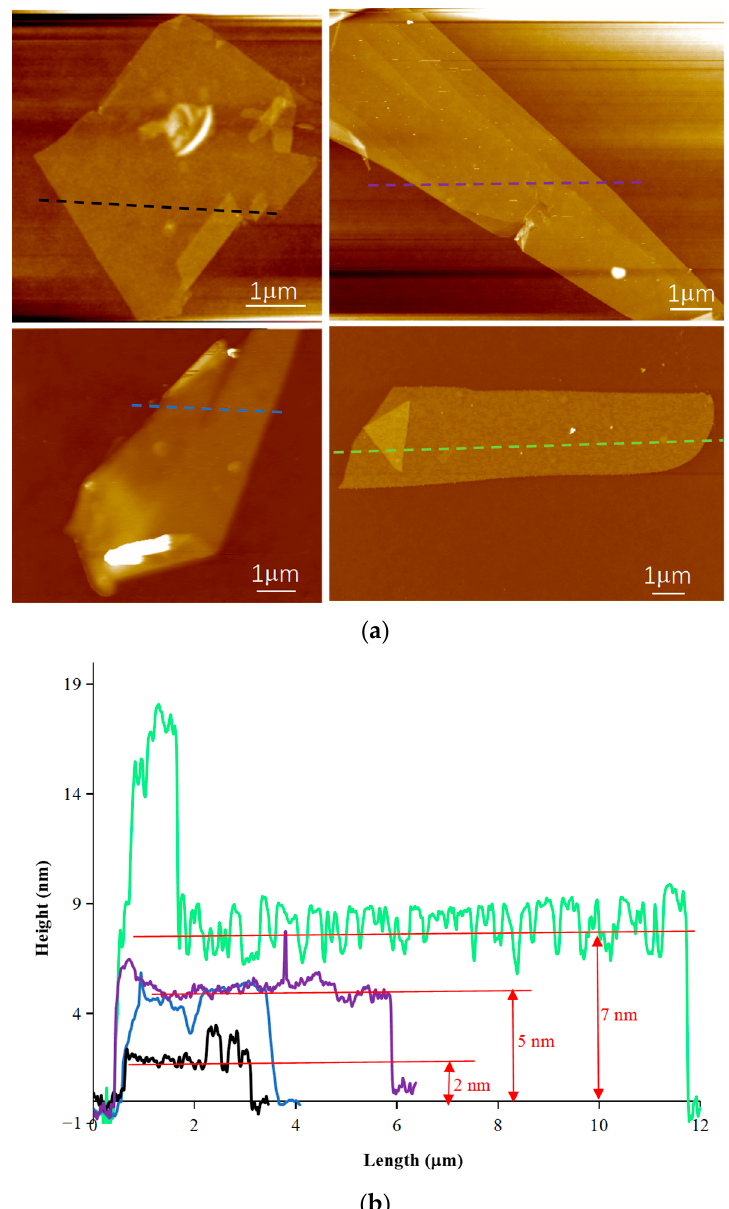
Figure 5. ( a ) AFM morphology of h-BN flakes with different thicknesses. ( b ) Height of h-BN flakes corresponding to the different colored dashed lines in Figure 5a.